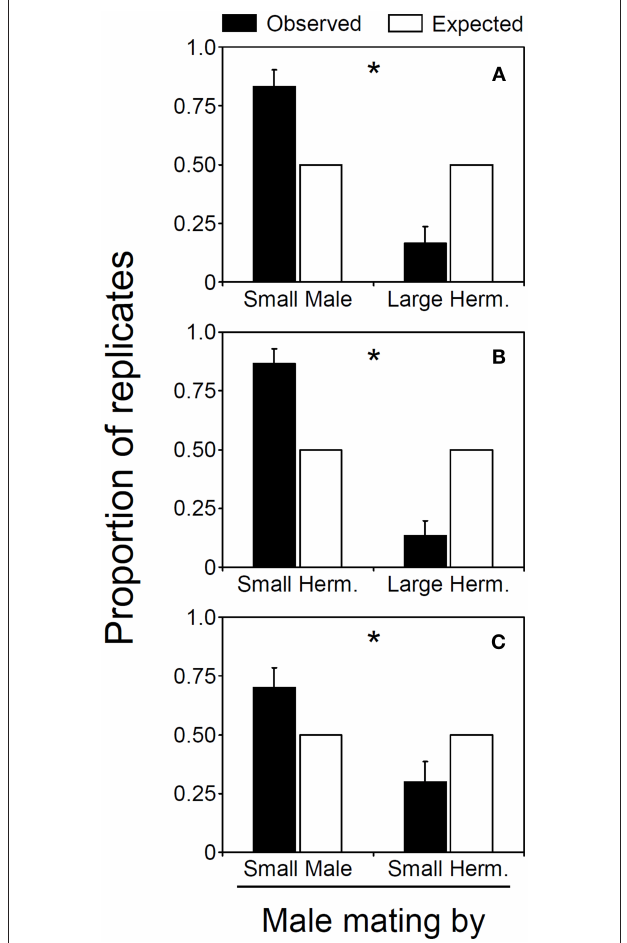
FIGURE 1 | Male mating ability of males and hermaphrodites in Lysmata wurdemanni . (A) small male versus large hermaphrodite. (B) small hermaphrodite vs large hermaphrodite. (C) small male versus small hermaphrodite. Observed and expected proportion of the replicates in which males or hermaphrodites inseminated parturial hermaphrodites. Error bars are binomial standard errors (for details see section Materials and Methods). Asterisks denote significant differences between observed and expected random mating